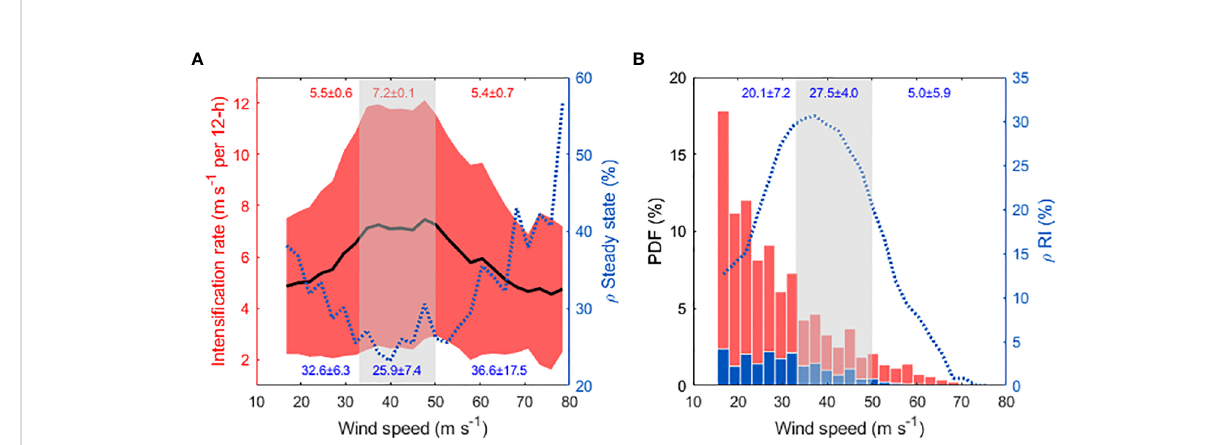
FIGURE 4 (A) The distribution of the mean intensi fi cation rate (solid black line; unit: m s − 1 per 12-h) in intensi fi cation cases and the probability of the achievement of a steady-state (dotted blue line). The red shaded area shows the ±1 s interval of the intensi fi cation rate. The intensi fi cation rate and the achievement of a steady-state are smoothed with a window width of 5.1 m s − 1 . (B) The probability density function distribution of the intensi fi ed cases (red bars) over 24 hours and rapid intensi fi cation cases (blue bars). The blue dashed line indicates the probability of rapid intensi fi cation in the intensi fi cation cases. The gray shaded area indicates the reduced drag coef fi cient wind range. The mean values of each variable for each wind section are shown at the top or bottom of the fi